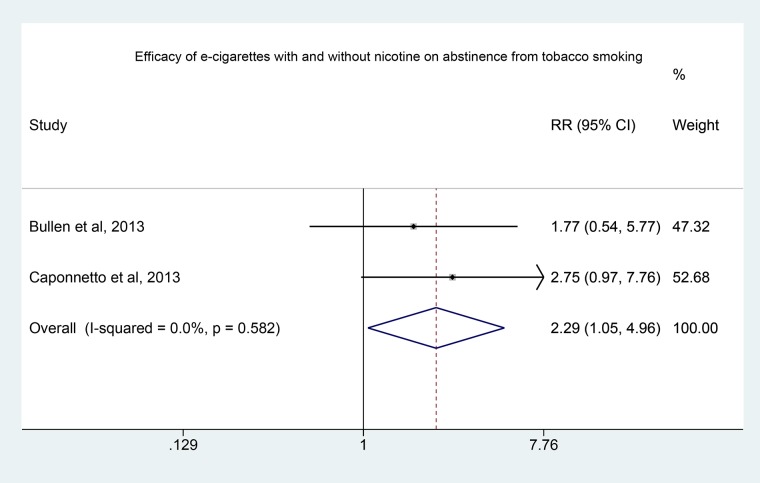
Forest Plot of the effectiveness of e-cigarettes with and without nicotine in smoking cessation.